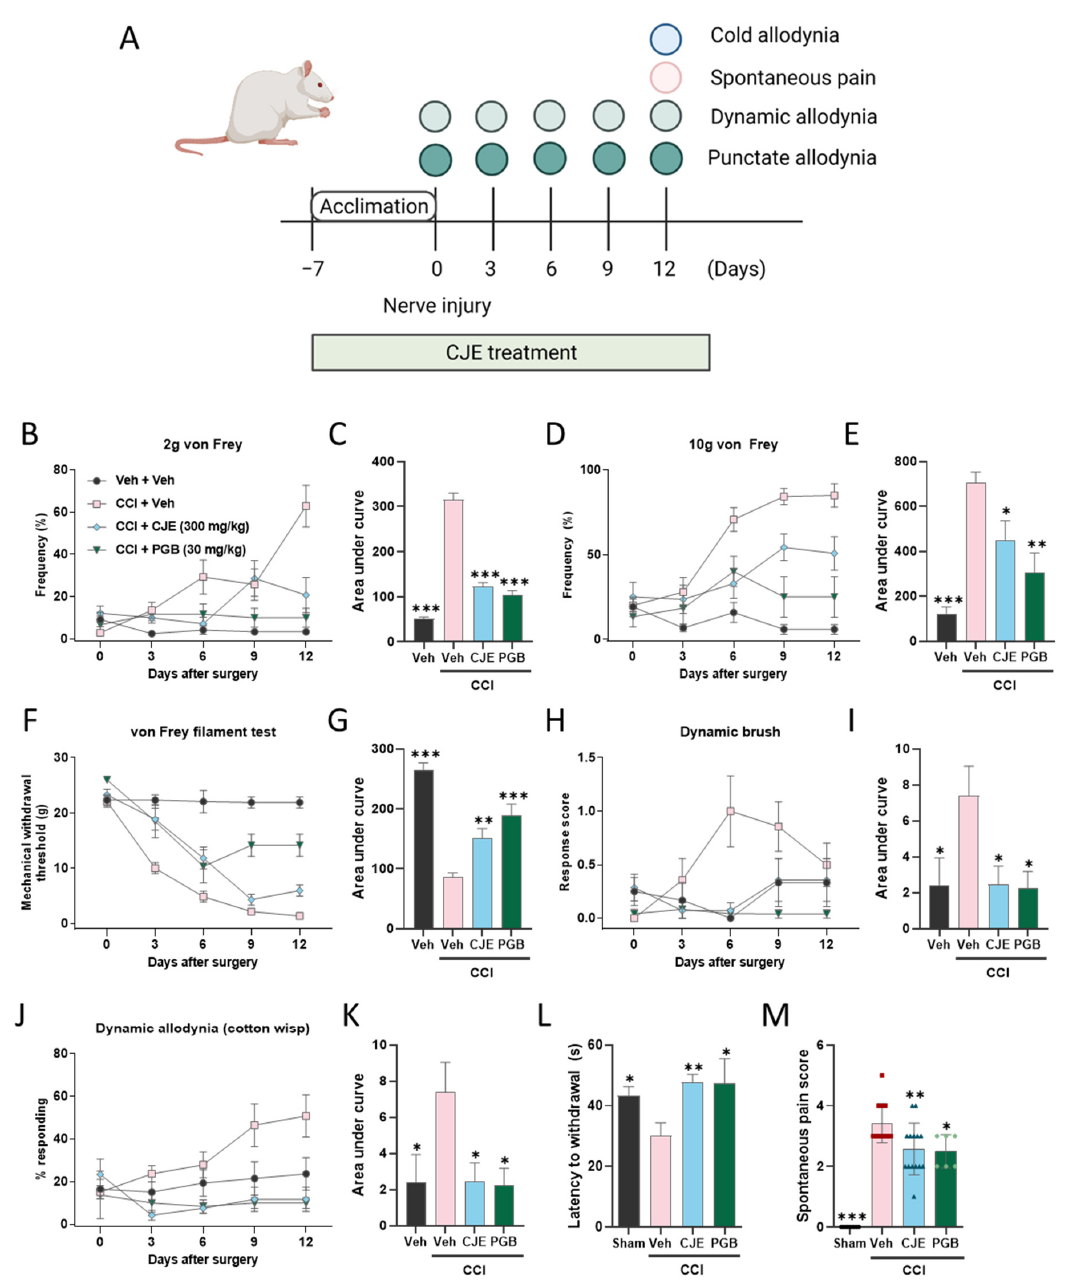
Figure 1. Effect of oral administration of Camellia japonica leaf extract (CJE) on pain sensitivity in a chronic constriction injury (CCI) model. ( A ) Experimental scheme of the pain-associated behavior test. Punctate allodynia was measured using the von Frey filament test. The paw withdrawal frequency elicited by ( B , C ) 2 and ( D , E ) 10 g von Frey filament stimulations. ( F , G ) The mechanical withdrawal threshold (MWT) was measured using a von Frey filament test. The area under the curve values for the paw withdrawal frequency elicited by 2 ( C ) and 10 g (E) von Frey filament stimulations, and the MWT ( G ). Dynamic allodynia was elicited using a dynamic brush test ( H , I ) and cotton wisp ( J , K ). The area under the curve values for the dynamic brush test ( I ) and cotton wisp ( K ). ( L ) Cold allodynia was measured using a cold plate test. ( M ) Spontaneous pain scores 12 days after CCI surgery. Black dots, red rectangles, blue triangles and green dots represent sham, CCI with the vehicle, CCI with CJE, and CCI with PGB, respectively. Data are presented as the mean ± SEM ( n = 6–14) and analyzed using a one-way ANOVA by Dunnett’s post hoc test; * p < 0.05, ** p < 0.01, and *** p < 0.001 compared with CCI with vehicle treatment